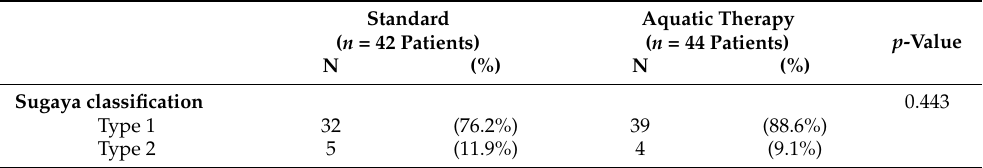
Table 3. Comparisons of post-operative tendon healing and patient satisfaction between the standard and aquatic therapy